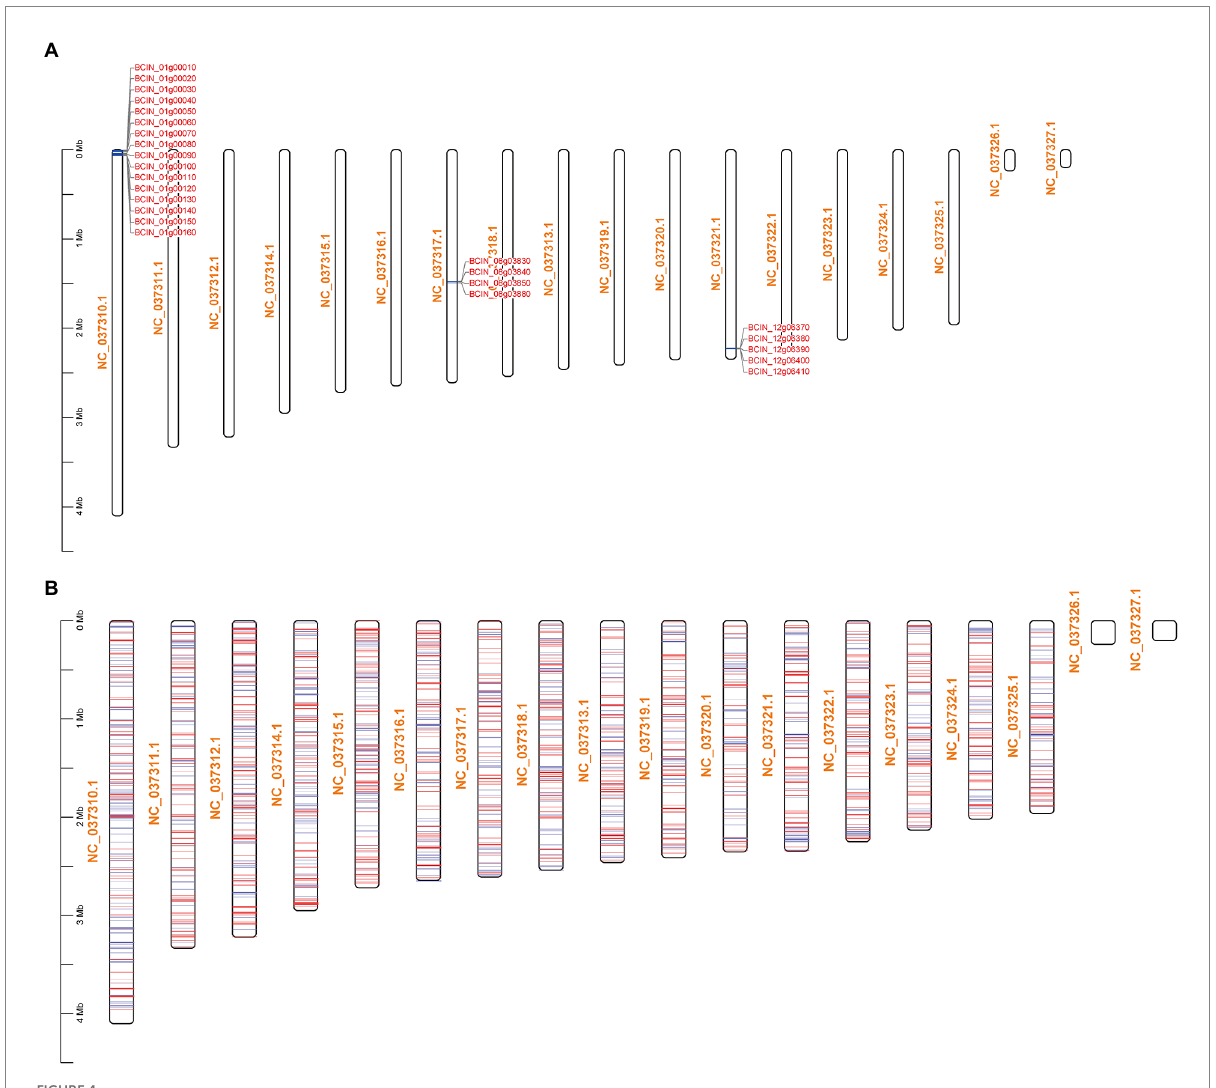
FIGURE 4 Schematic of DEGs mapping across chromosomes. NC_037310.1-NC_037327.1 are the numbers of the 16 chromosomes of B. cinerea . (A) BCIN_01g00010-BCIN_01g00160 are BOA synthetic gene cluster, BCIN_08g03830-BCIN_08g03880 are ABA synthetic gene cluster, and BCIN_12g06370-BCIN_12g06410 are BOT synthetic gene cluster. (B) The mapping of all DEGs on chromosomes, the red line represents genes with upregulated transcription level, and the blue line represents genes with downregulated transcription